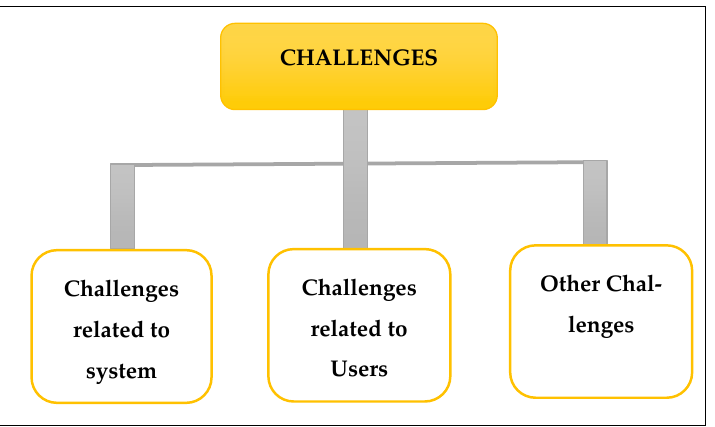
Figure 12. Challenges sections.